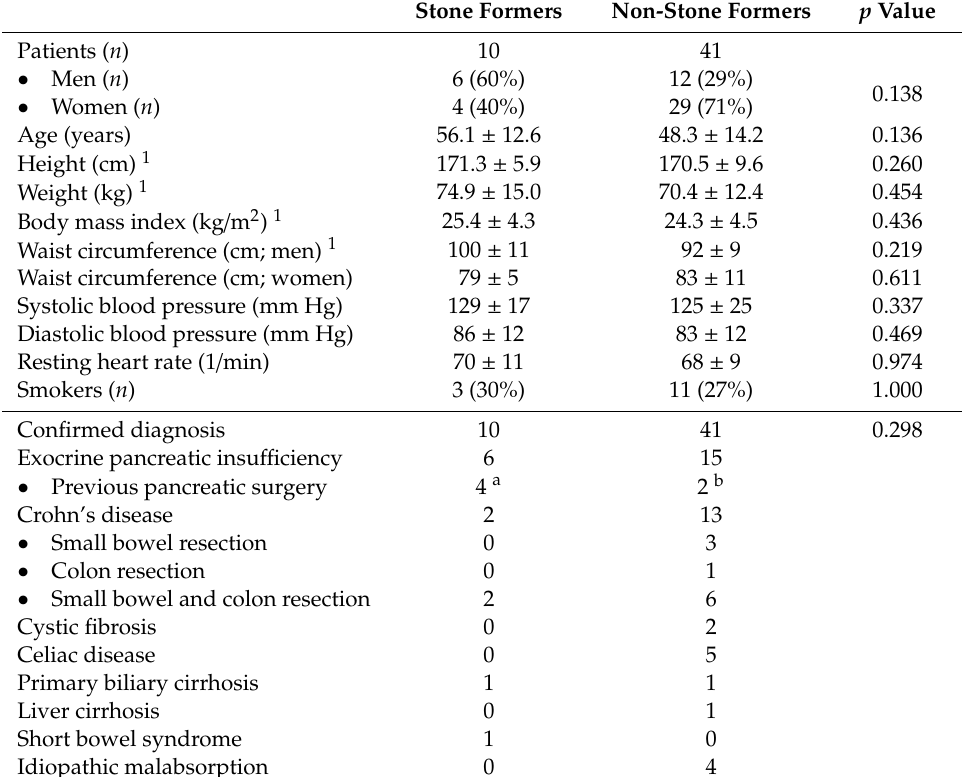
Table 1. Baseline patient